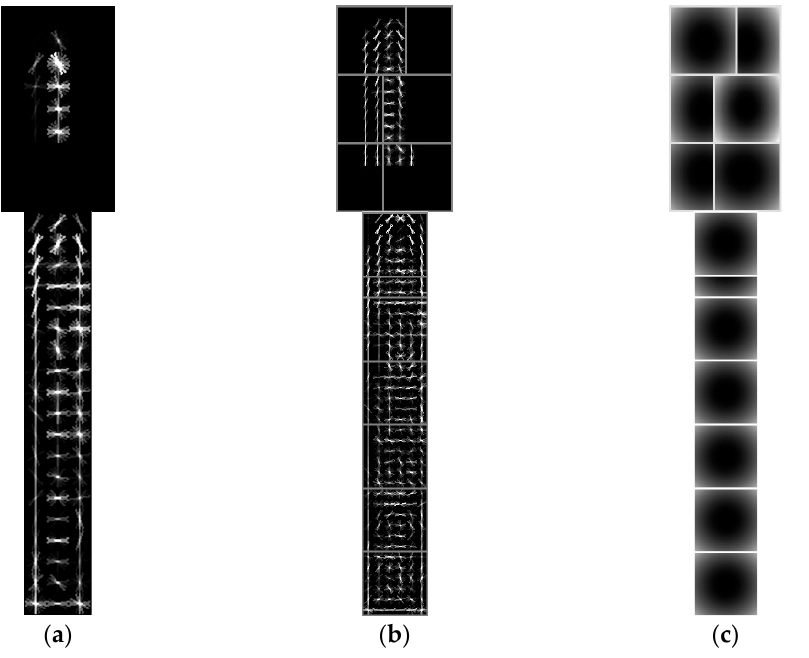
Figure 5. Key part sub-model and whole ship sub-model. ( a ) Root model; ( b ) Part model; ( c ) Spatial location models.